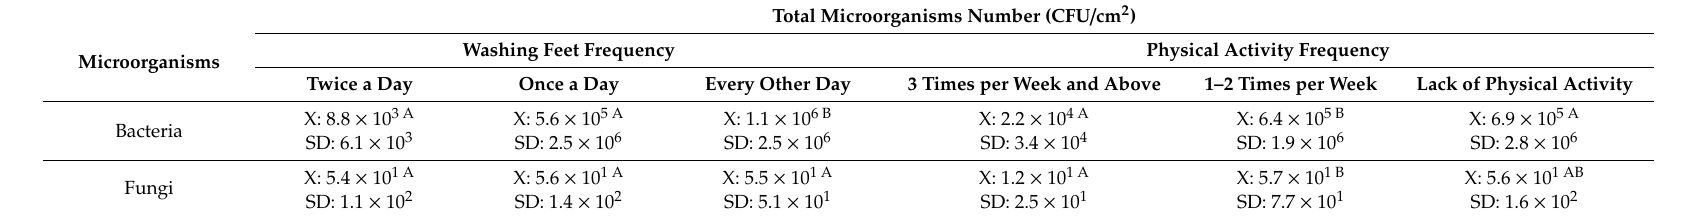
Table 2. Total number of bacteria and fungi depending on washing feet and physical activity frequency